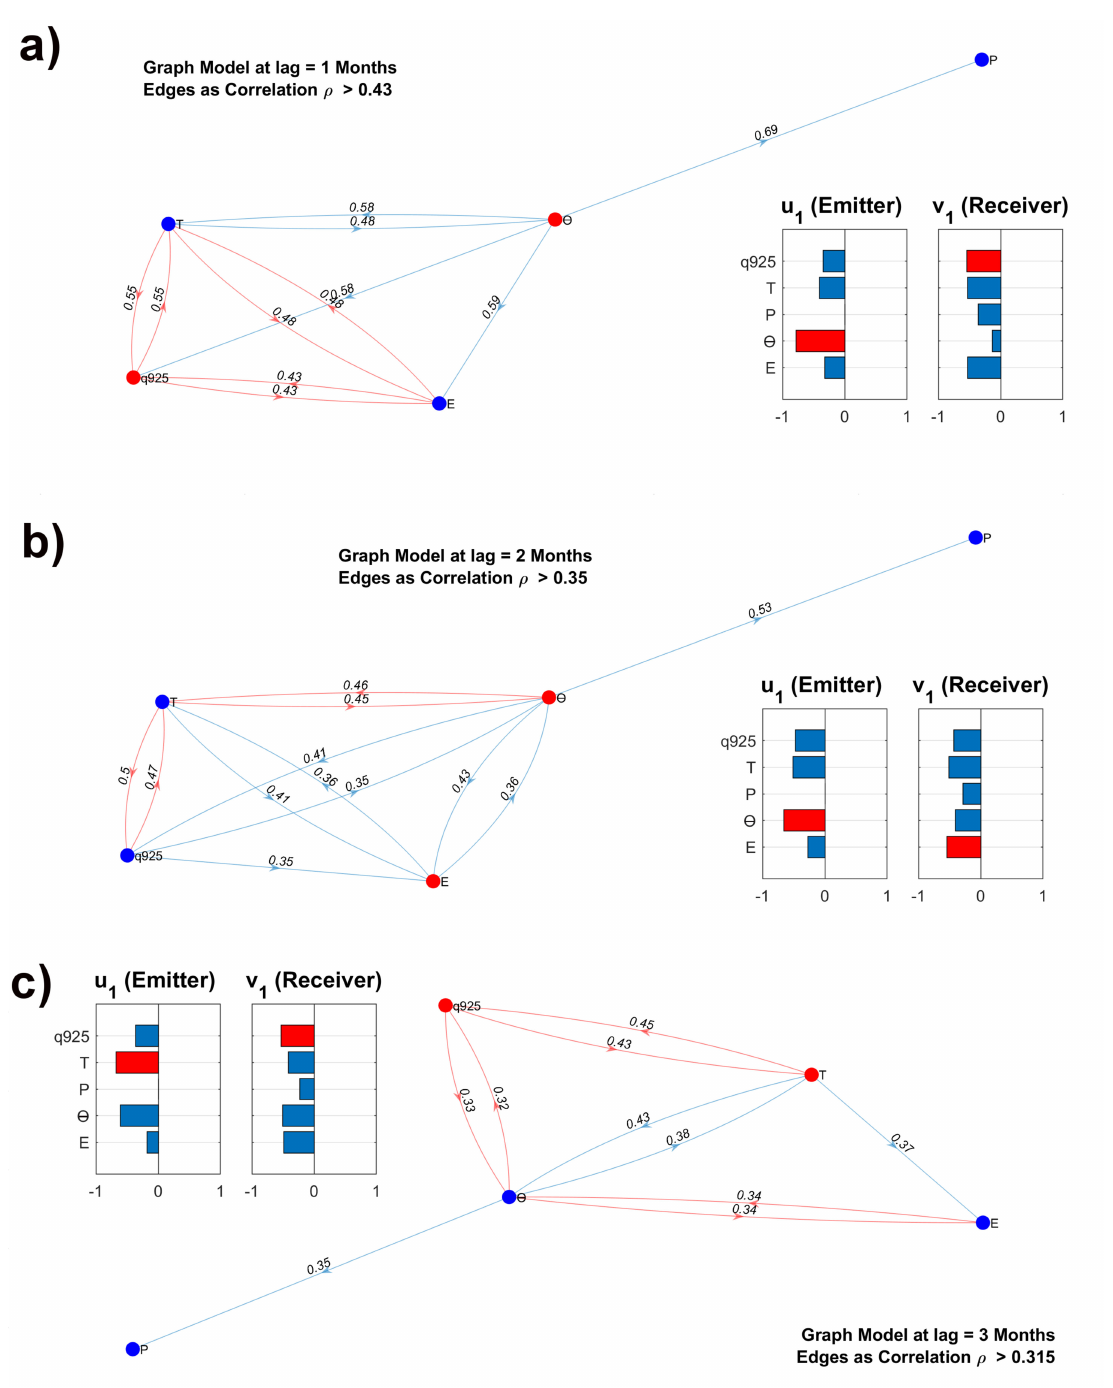
Figure 6. Correlation graphs constructed with the highest ENSO-related modes from each pair of variables. The weights of the linkages between nodes are estimated as the lagged correlation among MCA-series. Red linkages represent feedbacks between variables. Leading SVD vectors u 1 and v 1 are estimated from the adjacency matrix associated with the graph and represented with red nodes. Red bars also represent the highest values of these vectors. ( a ) one-month lag graph; ( b ) two-month lags graph; ( c ) three-month